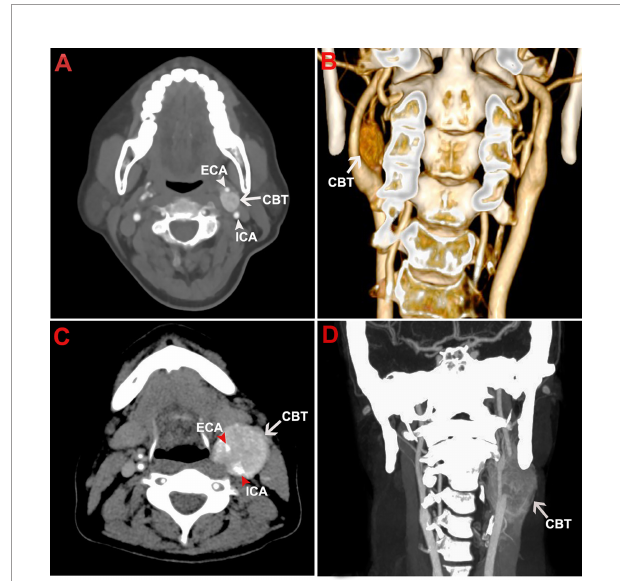
FIGURE 1 | Representative CTA images of CBT. The fi gure shows the representative CTA images of a Shamblin type I CBT in axial view (A) and coronal view (B) . CTA images of a Shamblin type III CBT were shown in axial view (C) and coronal view (D) . The tumor lesions displayed typical radiographic characteristics of CBTs with localization at carotid bifurcation, splaying of carotid arteries, and hypervascularity. No encasement and complete encasement to ICA or ECA were noticed in Shamblin I (A, B) and Shamblin III lesions (C, D) , respectively. CBT, carotid body tumor; CTA, computed tomography angiography; ICA, internal carotid artery; ECA, external carotid